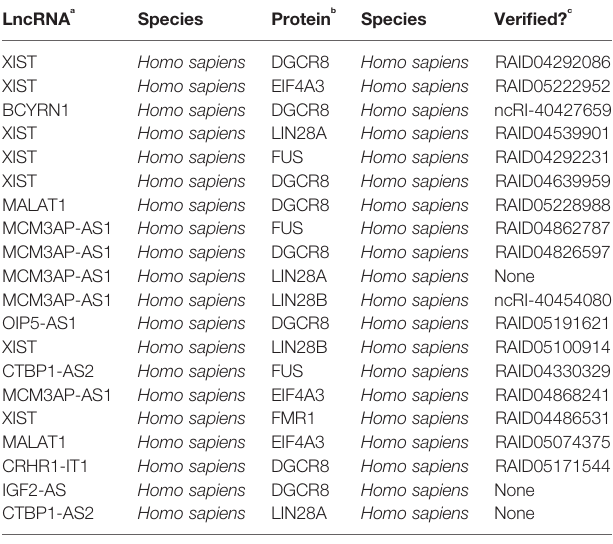
TABLE 2 | 20 top-ranked predictions from this